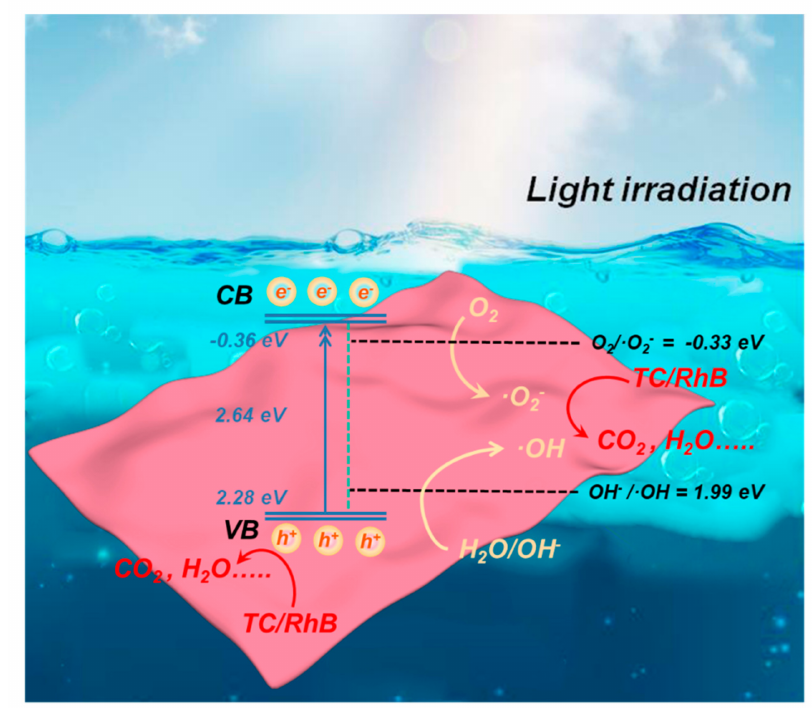
Figure 8. Schematic illustration of the proposed photocatalytic mechanism in the F-BFTOC for the degradation of